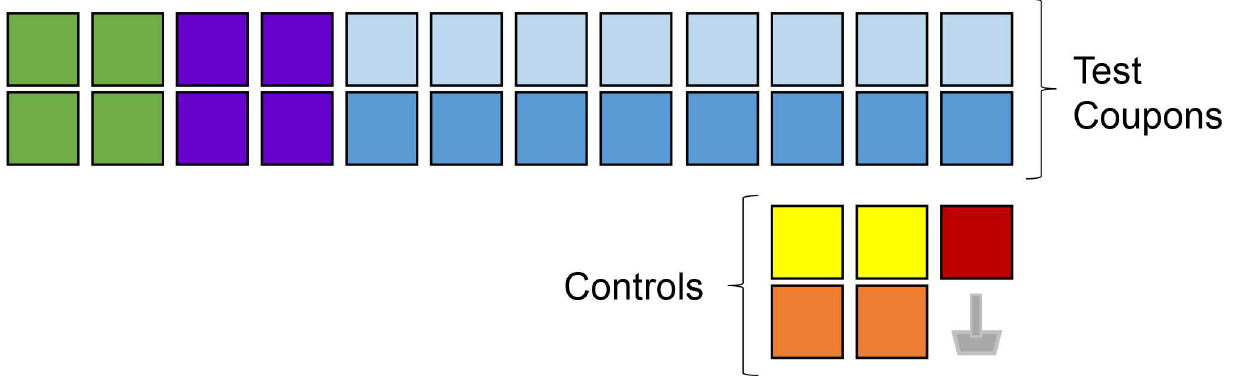
Fig 3. Pictorial overview of the test design used to compare the single media single pass composite (SM-SPC) method with the single media multi pass composite (SM-MPC) method. Each method was tested using 4 or 8 locationscomposited.On one test day, all locations for all tests were contaminated. On the other test day, only one random location was contaminated.Gray Sponge: Negative Process Control. Each square represents an individualcoupon location. Green: SM-SPC method with 4 coupons; Purple: SM-MPC method with 4 coupons; Light Blue: SM-SPC method with 8 coupons; Dark Blue: SM-MPC method with 8 coupons; Yellow: SP-Discrete serving as process control for the SM-SPC; Orange: MP-Discrete serving as process control for the SM-MPC; Red: Negativecontrol coupon.